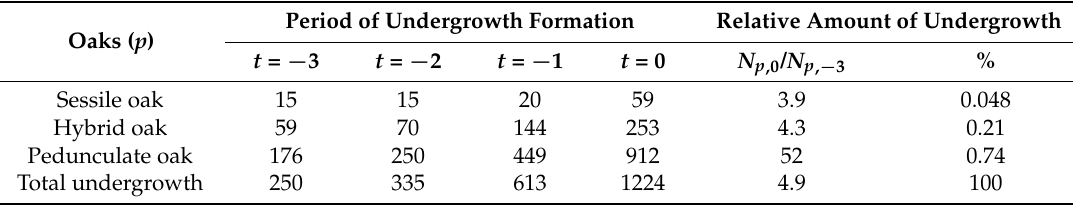
Table 2. The total amount ( N p,t ) of oak trees in the undergrowth in plots dependent on the formation period ( t ) in years (Equation